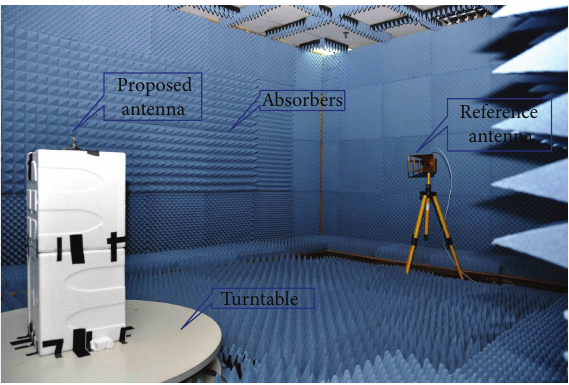
Figure 15: Illustrations of the anechoic